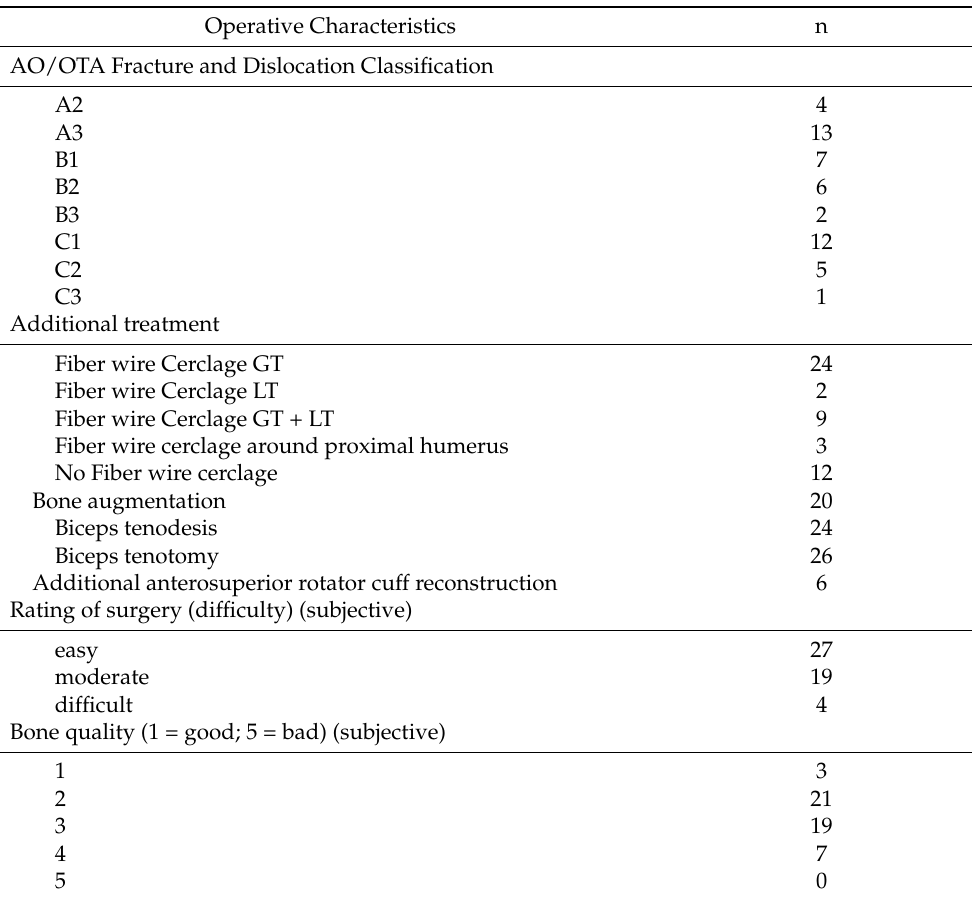
Table 1. Fracture classifications, operative characteristics and intraoperative assessment for all included patients (n =